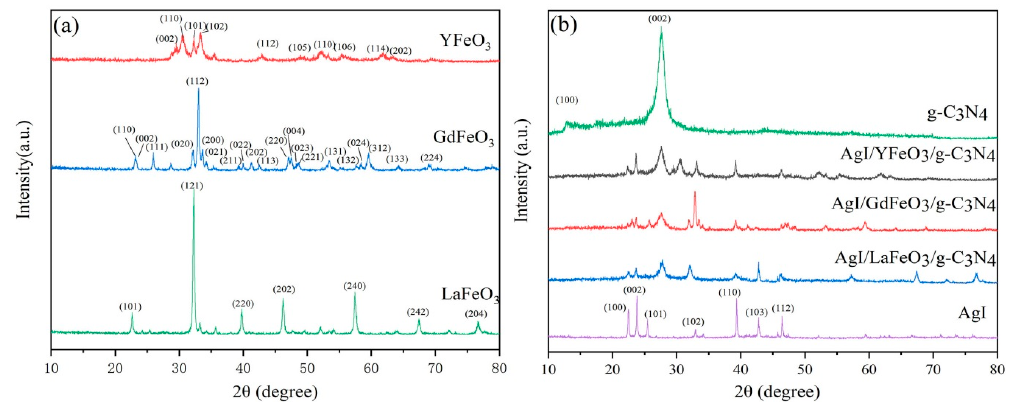
Figure 1. ( a ) The XRD patterns of AgI, g-C 3 N 4 , and AgI/MFeO 3 /g-C 3 N 4 (M = Y, Gd, La) samples and ( b ) MFeO 3 (M = Y, Gd, La).